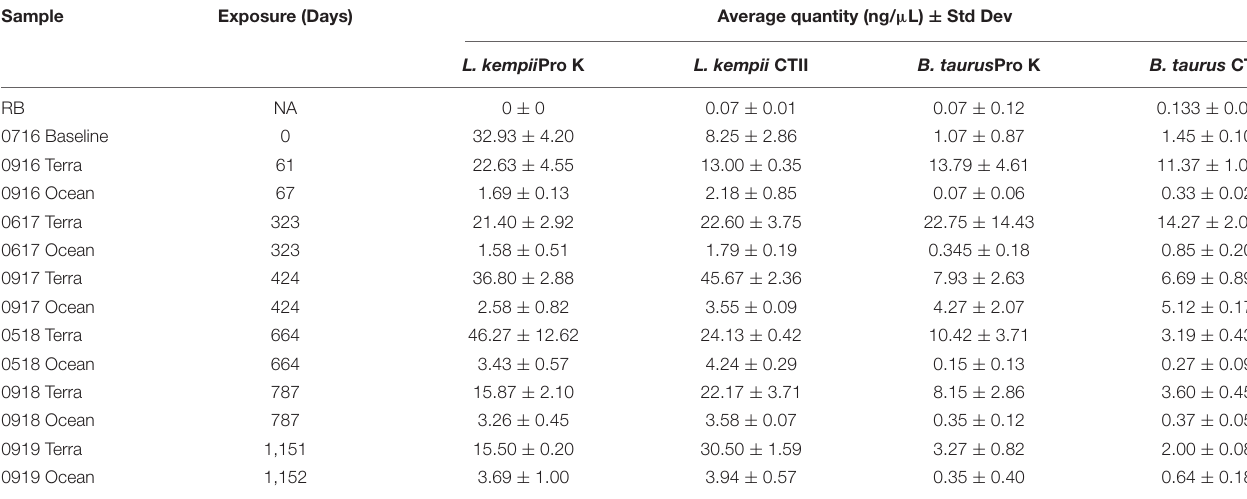
TABLE 1 | Average and standard deviation values for DNA concentrations following DNA extraction from bone for Pro K and CTII treatment.